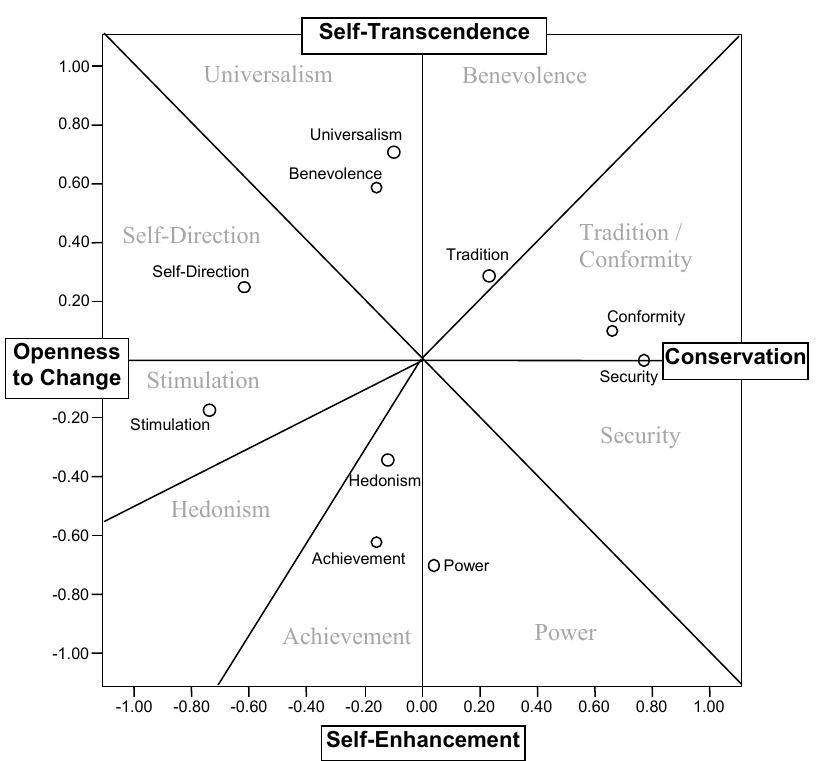
Figure 1. Value circle measured with 10 items from the PVQ21 selected by the WVS and theoretical segmentation of the field based on Schwartz (1992); plot of the Varimax-rotated component loadings in our sample.